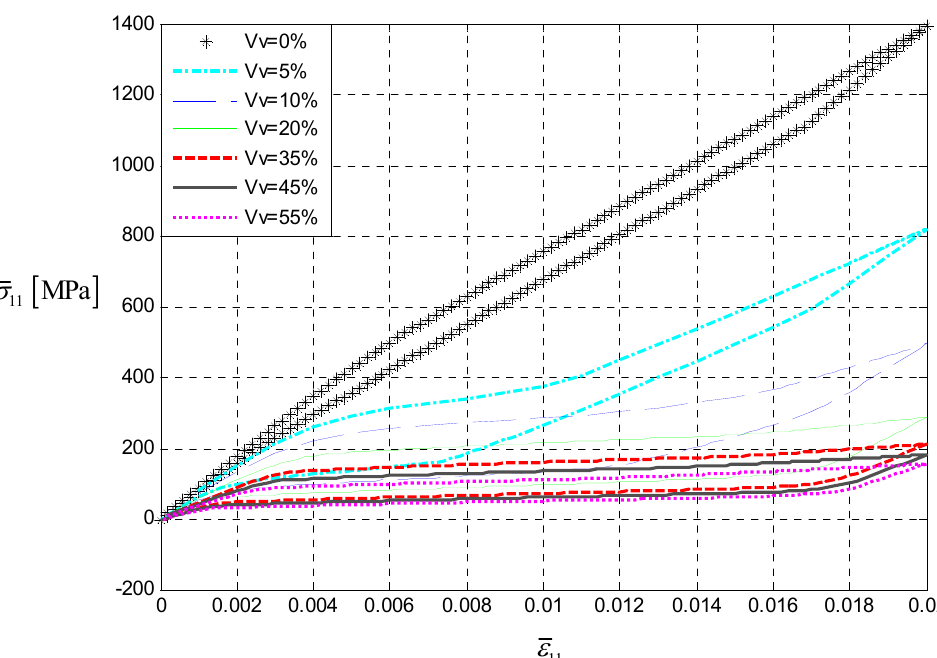
x -direction for the first loading 1